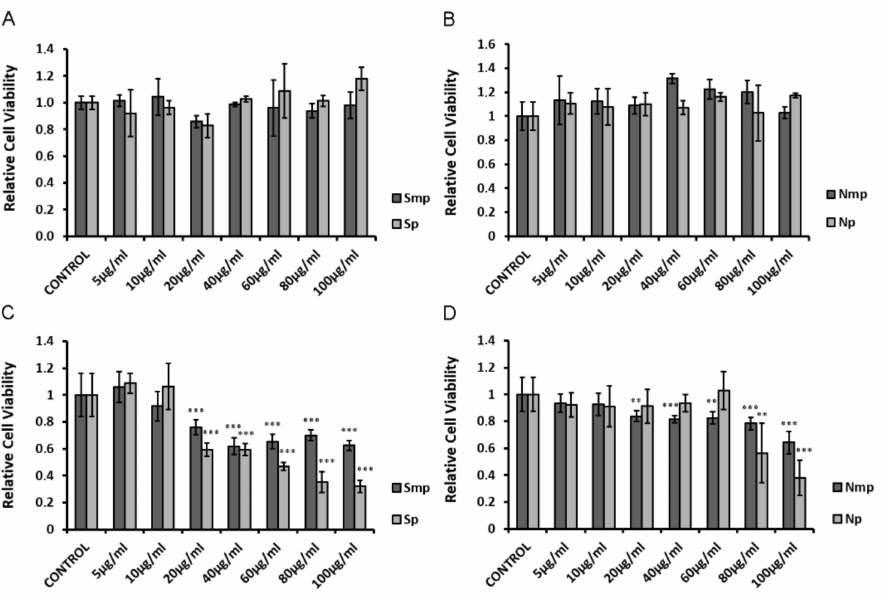
Figure 1. Evaluation of the effect of the Southern ( A , C ) and Northern ( B , D ) medium-polar (mp) and polar (p) leaves fractions on cell viability of HEK293 cells. Cell viability was assessed by MTT assay at two time points, 6 h ( A , B ) and 48 h ( C , D ). Relative cell viability is expressed as cell viability of the fractions at the indicated concentrations compared to control vehicle-treated cells. Cell viability of control cells was set at 1. Data are expressed as the mean ± SD, ( n = 5–9), ** p < 0.01; *** p <